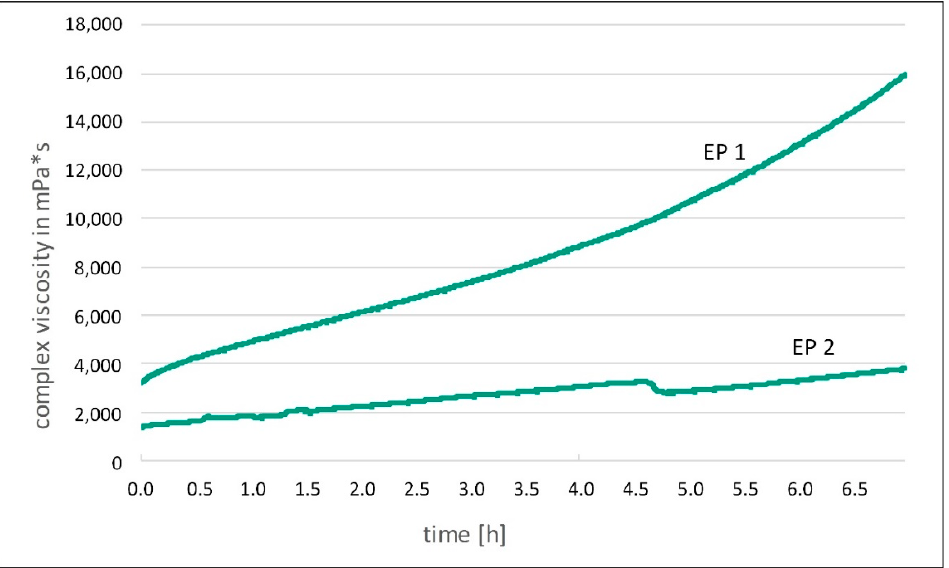
Figure 6. Complex viscosity long-time measurement at room temperature .